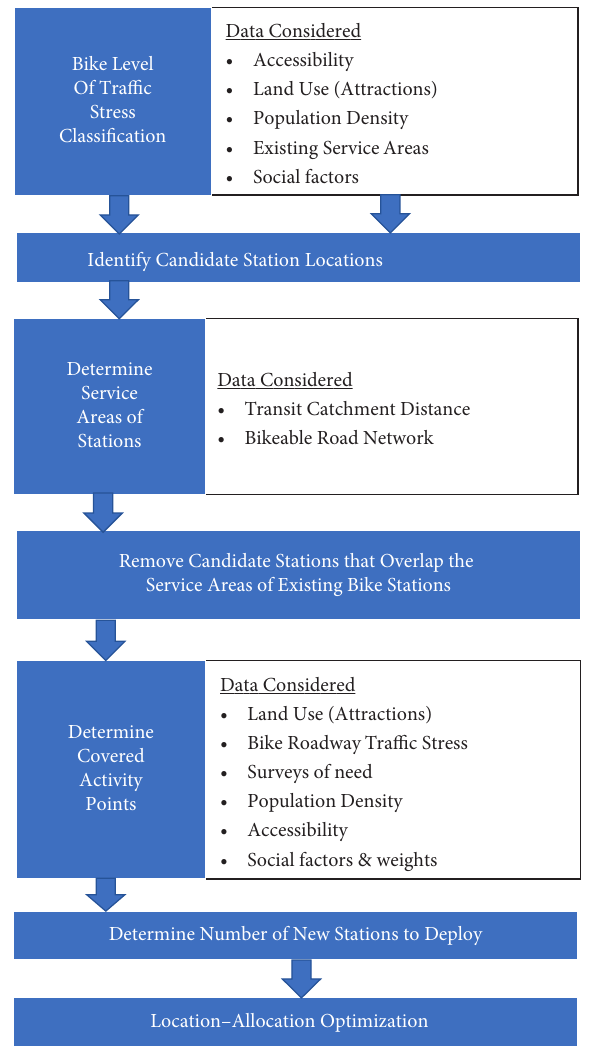
Figure 2: Workflow for the location-allocation optimization model. Table 1: Dataset used for the location optimization